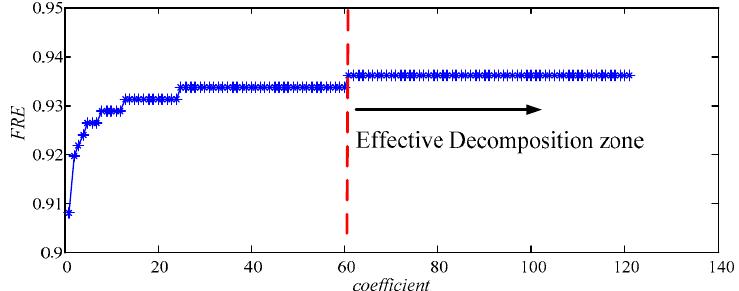
Figure 8. The feature energy ratio ( FER ) value distribution diagram of all F 2 based on the simulated signal .